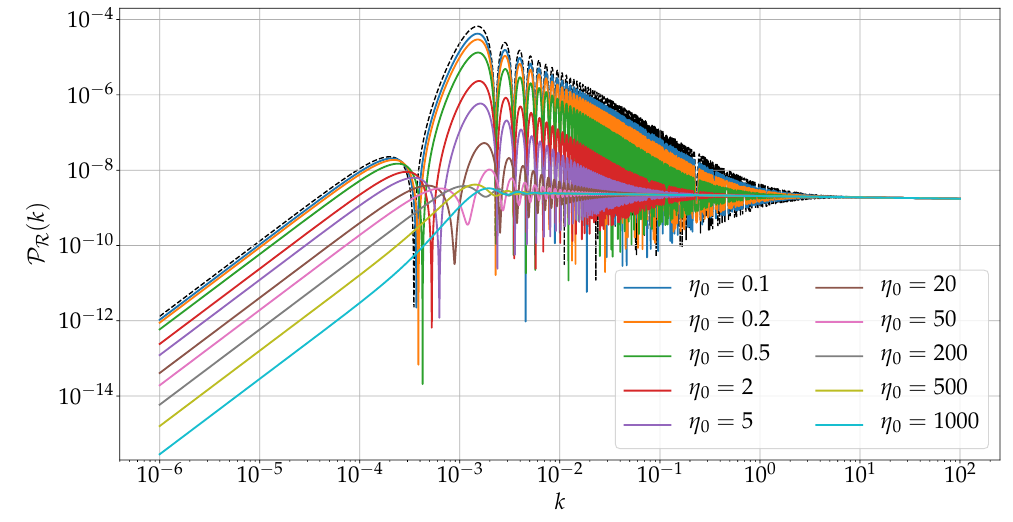
Figure 10. Primordial scalar power spectrum in hybrid LQC of the 0th-order adiabatic vacuum, defined with the different choices of initial time displayed in Figure 9. The background is the solution studied in Section